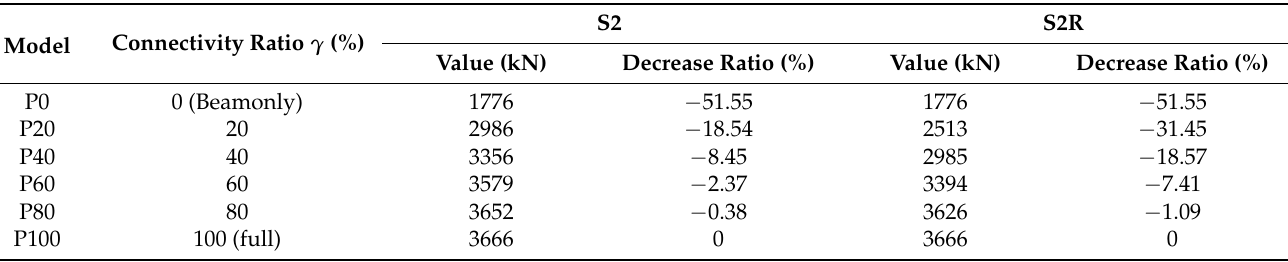
Table 4. Results of shear strength for S2 and S2R